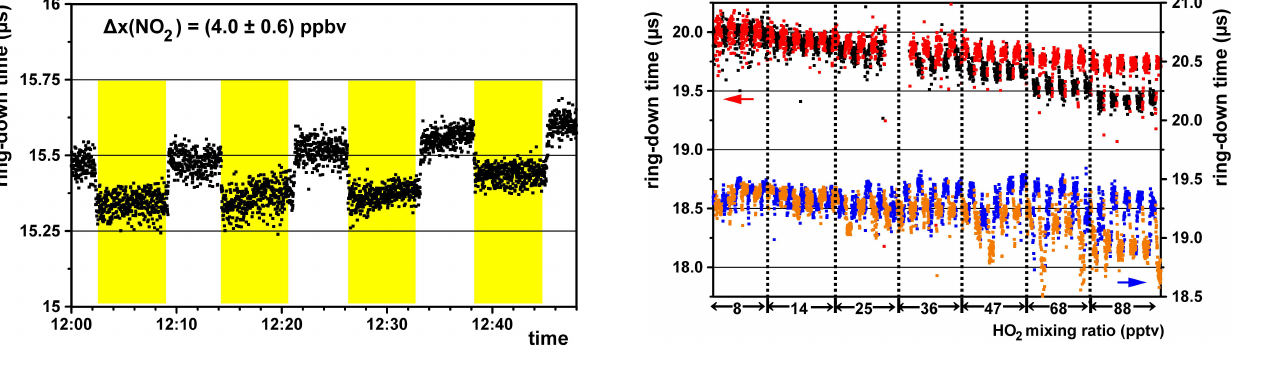
Fig. 10. Measurement of the maximum ozone concentration gener- ated by the radical source. Periods with UV light entering the source are marked in yellow.